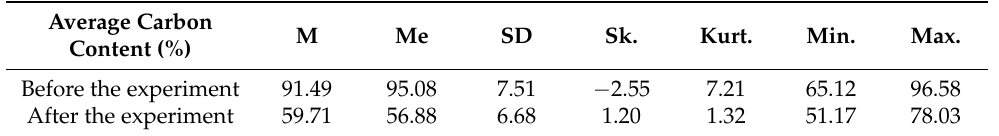
Table 2. An average carbon content in the rubber material before and after realizing the experiments (30 control samples) with basic descriptive statistics: mean, median, standard deviation, skewness, kurtosis, minimum, and maximum value, respectively.